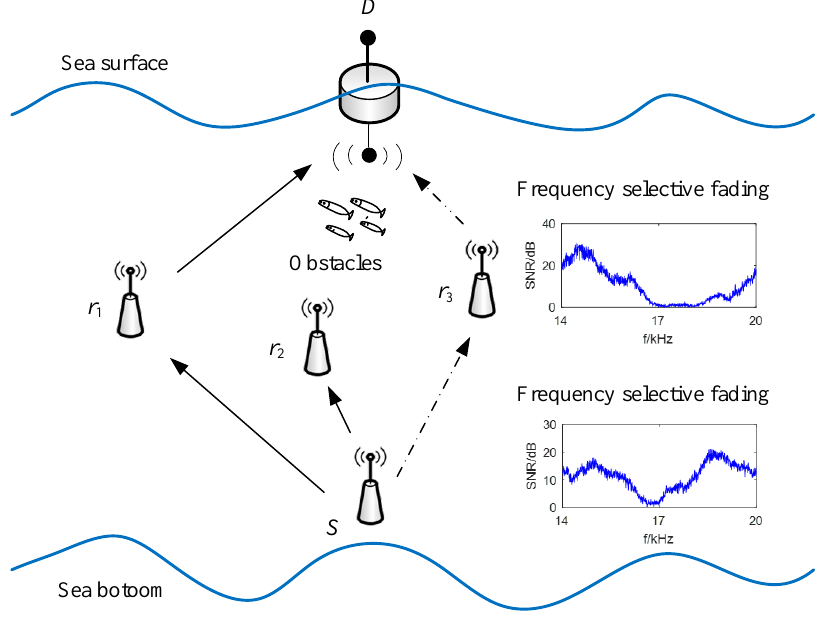
Figure 2. The impact of obstacles and frequency selective fading on relay